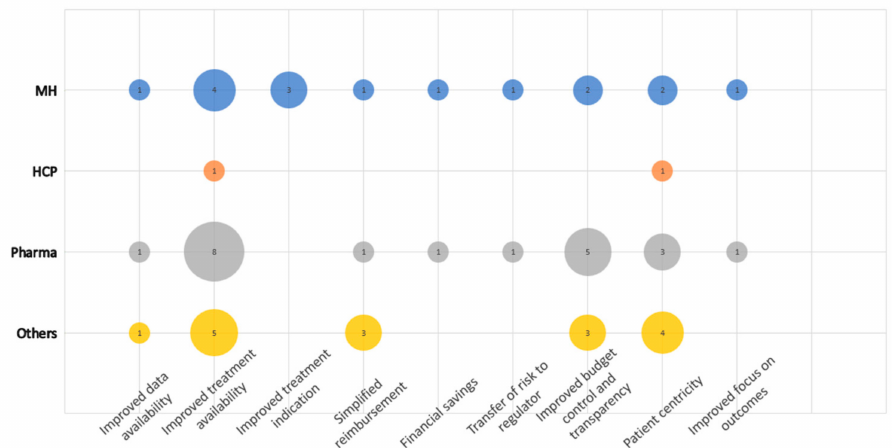
Figure 3. Opportunities: frequency chart of codes in defined sub-categories within the category opportunities related to the PB MEA implementation by occupational